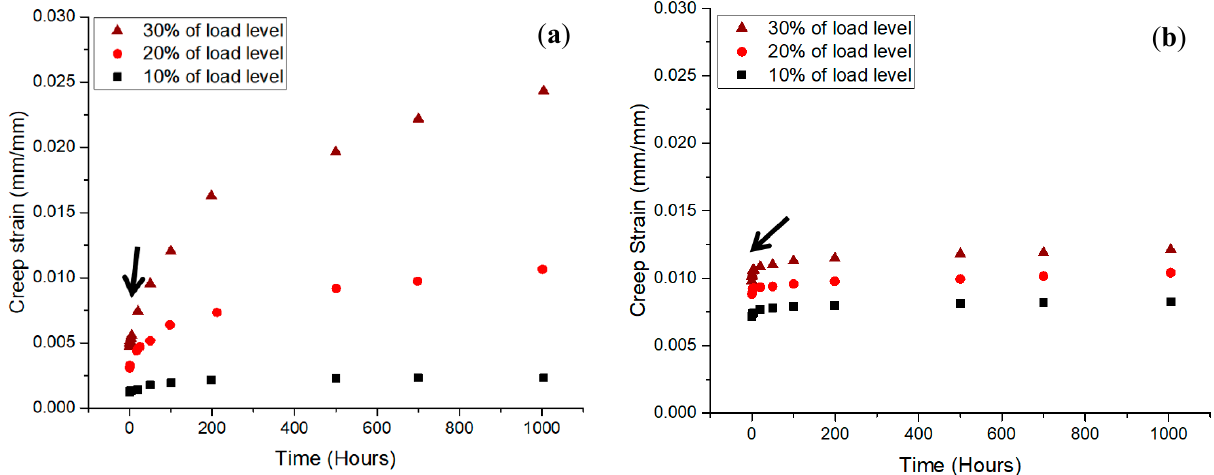
Figure 6. Creep strain against time at different load levels for ( a ) wood and ( b ) pGFRP specimens. Reproduced with copyright permission from Asyraf et al. [26].